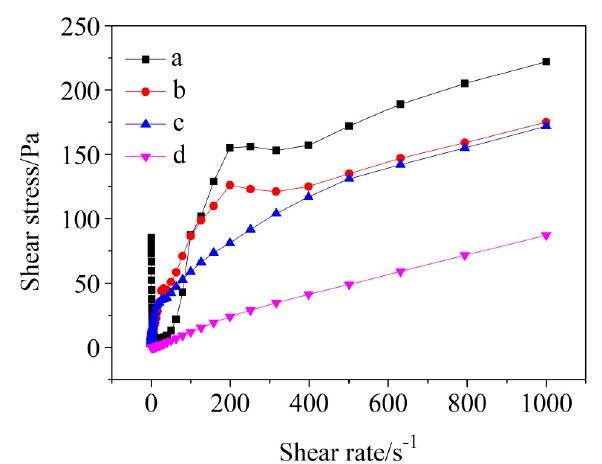
Figure 5. Shear stress versus shear rate curves for cement-water slurries added with different amounts of SHMP: (a) without SHMP, (b) with 0.1% SHMP, (c) with 0.2% SHMP, and (d) with 0.4% SHMP.